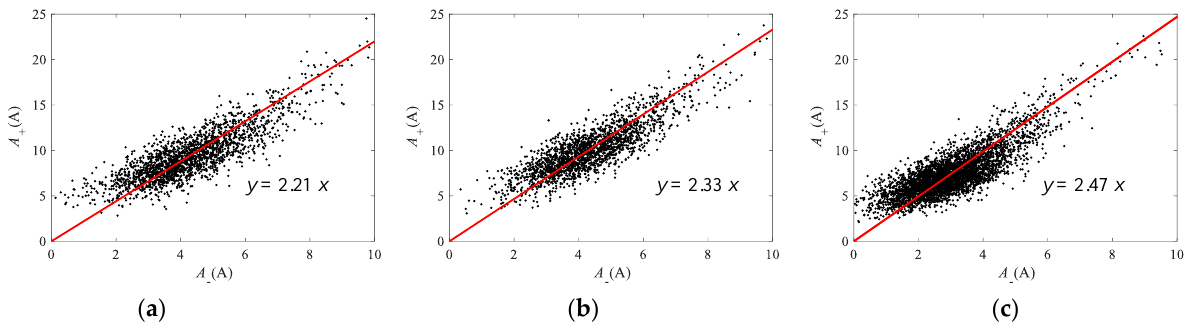
Figure 8. A + versus A − from one single current pulse at different conditions: ( a ) U = 20 kV, d = 5 mm; ( b ) U = 25 kV, d = 10 mm; and ( c ) U = 35 kV, d = 15 mm